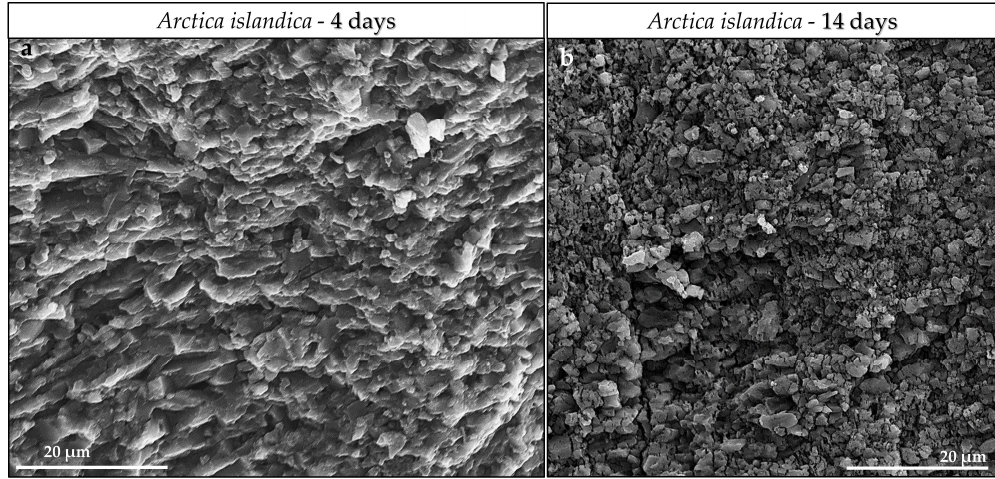
Figure 4. FE-SEM images of aragonite crystallite morphology and assembly after ( a ) 4 and ( b ) 14 days of conversion. We do not observe any major changes in crystallite morphology and size relative to that present in the pristine shell (compare Figure 4 to Figure